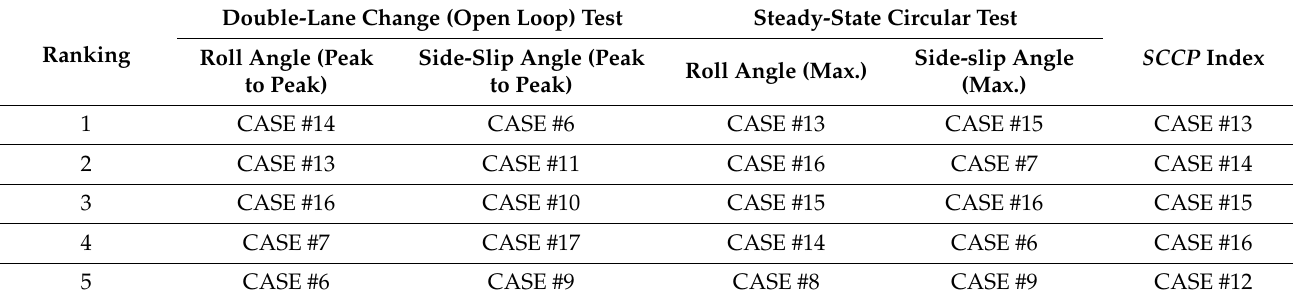
Table 5. Suspension cornering performance index